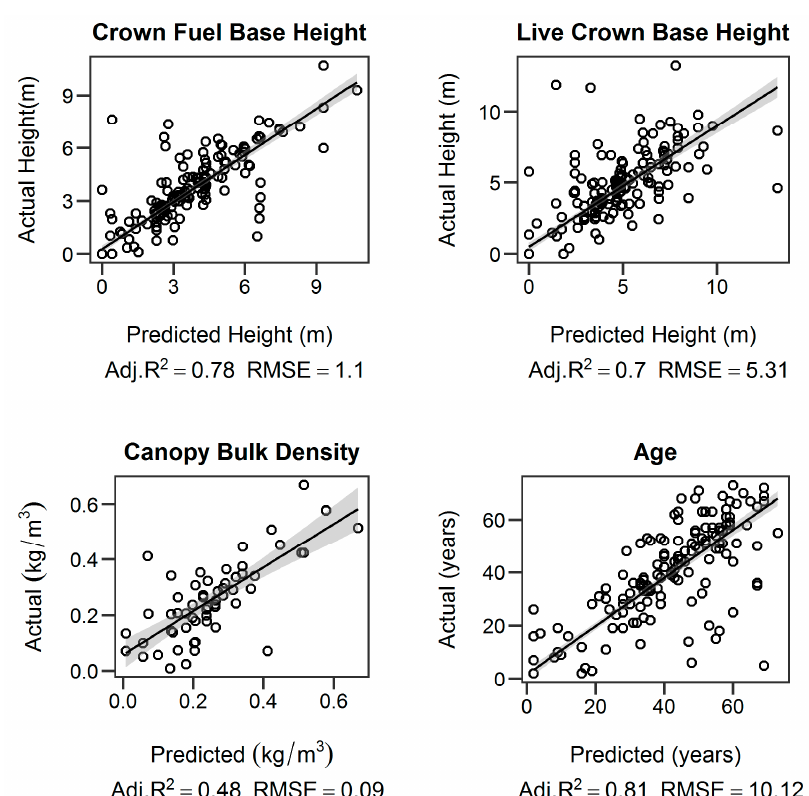
Figure 4. Plots comparing predicted versus observed values for each of the four imputed canopy fuel attributes. The least squares fit trend line is shown with the trend line standard error in transparent gray. Accuracy metrics are displayed in the form of the adjusted coefficient of determination (Adj. R2) and the root mean squared error (RMSE).